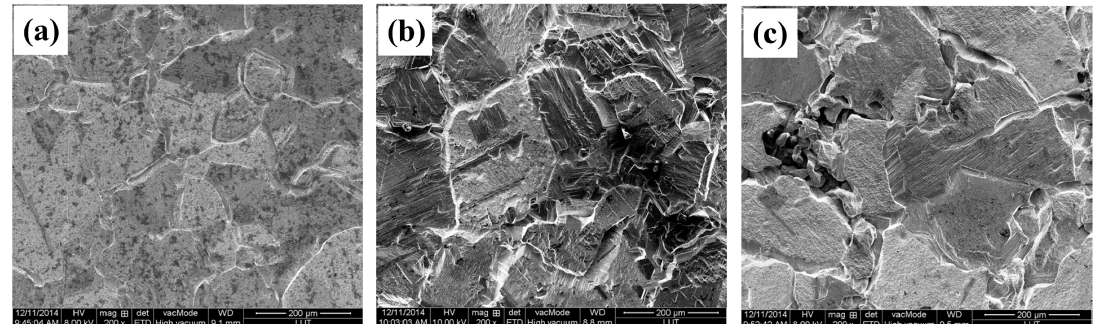
solution (a) base metal (b) wire-filled PAW joint (c) PAW joint 3